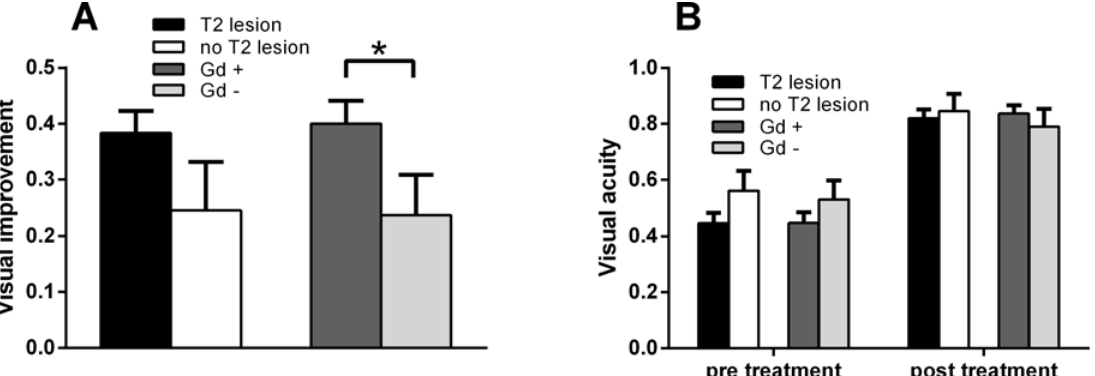
Figure 2. Patients with Gd enhancement of the optic nerve show significant higher visual improvement. (A) Mean improvement of visual acuity of patients with or without either T2 lesion or Gd enhancement of the optic nerve in orbital MRI. Error bars indicate standard error of the mean. * indicates significant difference with p = 0.04 as determined via Mann-Whitney rank sum test. Improvement of visual acuity was defined as difference between visual acuity before and after adequate treatment. (B) Mean visual acuity of patients with or without T2 lesion or Gd enhancement of the optic nerve in orbital MRI before and after adequate therapy. Error bars indicate standard error of the mean. No significant differences were found between the single groups.